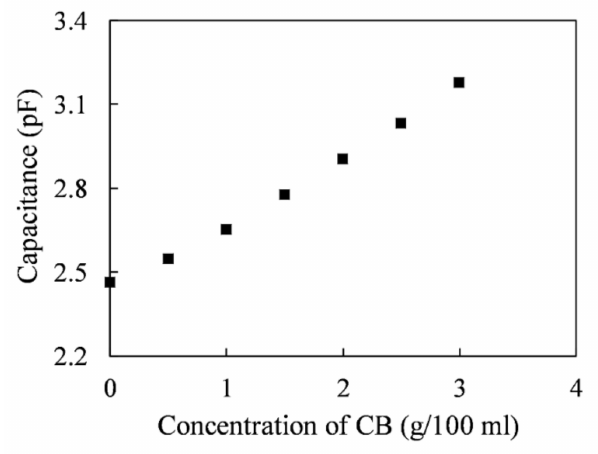
Figure 5. Measured capacitance increment of the carbon black.